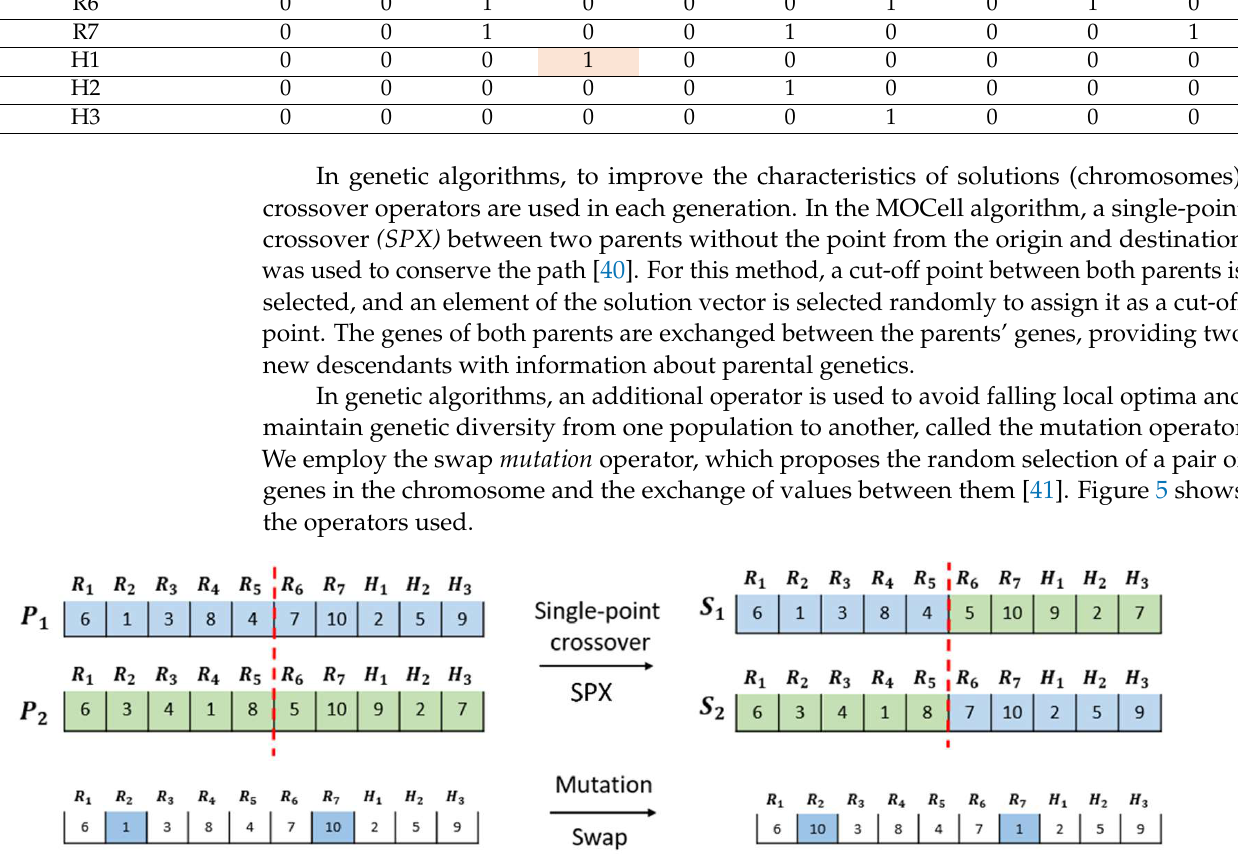
Figure 5. Genetic